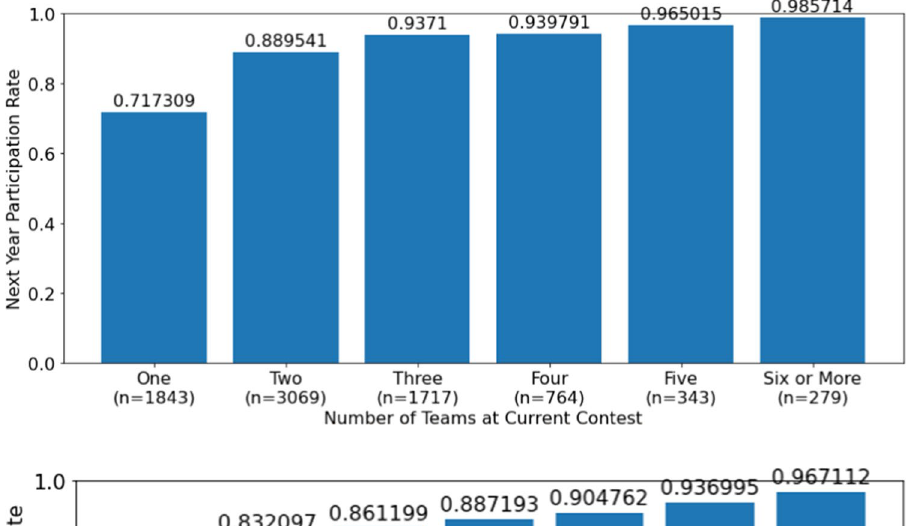
Fig. 4 Return rate as a func- tion of the maximum number of problems solved by any team from a given institution,